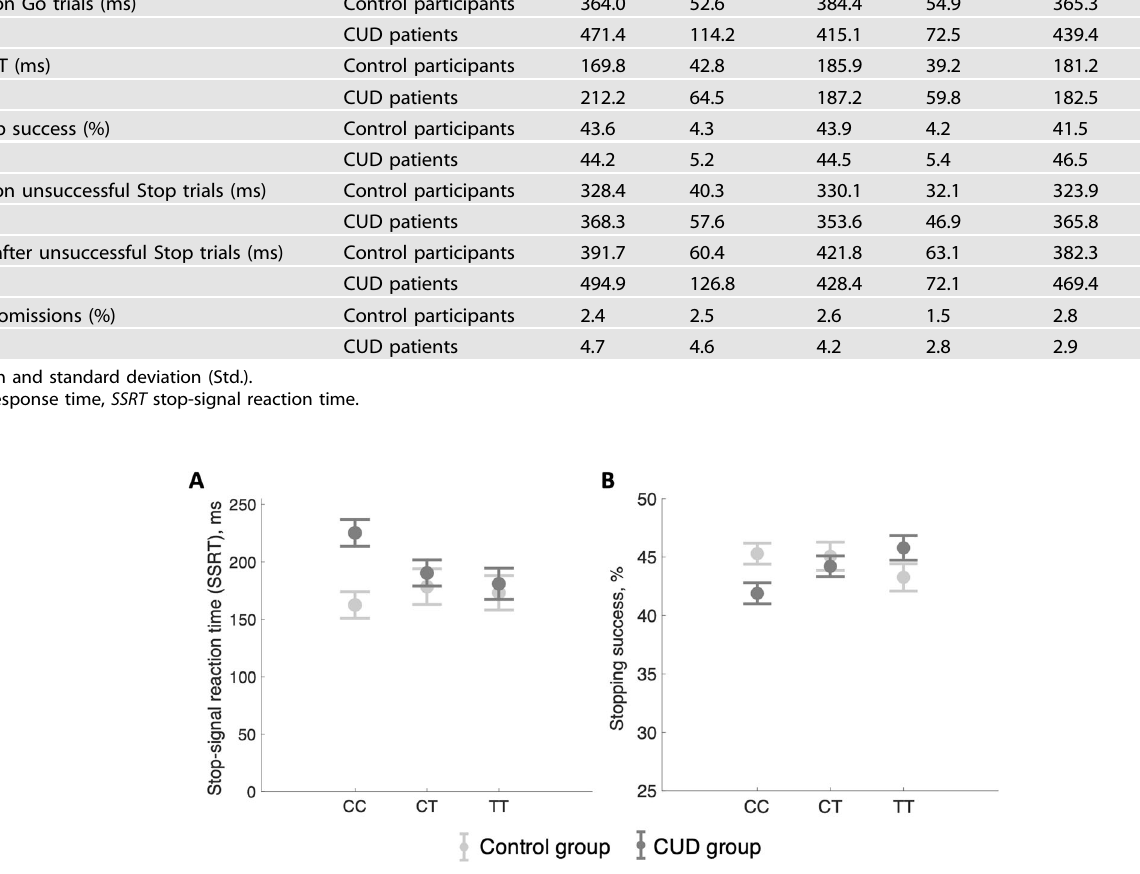
Fig. 1 Stop-signal task performance as per diagnostic group (control and CUD) and rs36024 SNP genotype (CC, CT and TT on x -axis). A SSRT was differently affected by genotype and diagnostic group, such that CUD patients with CC genotype showed signi fi cantly prolonged SSRT compared with CC control participants and TT CUD patients. B The percentage of successful stops was also differently affected by genotype and diagnostic group, such that CUD patients with CC genotype had fewer successful stops compared with both CC control participants and TT CUD patients. Error bars denote ±standard error of the